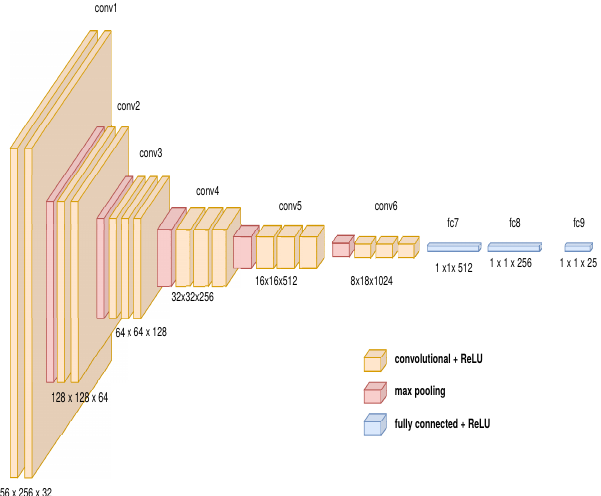
Figure 10. Convolutional model’s features for GAN’s discriminator.